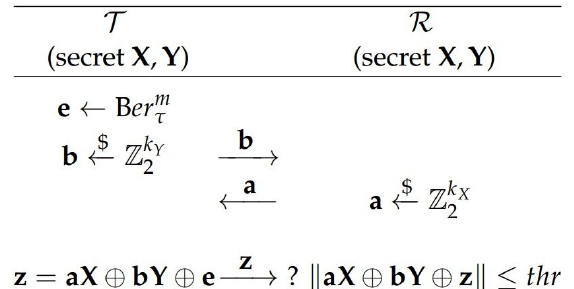
Figure 1. Random-HB# and HB# authentication protocols. Table 1. Standard parameter sets I and II for HB# and Random-HB# proposed in [11]. Number l